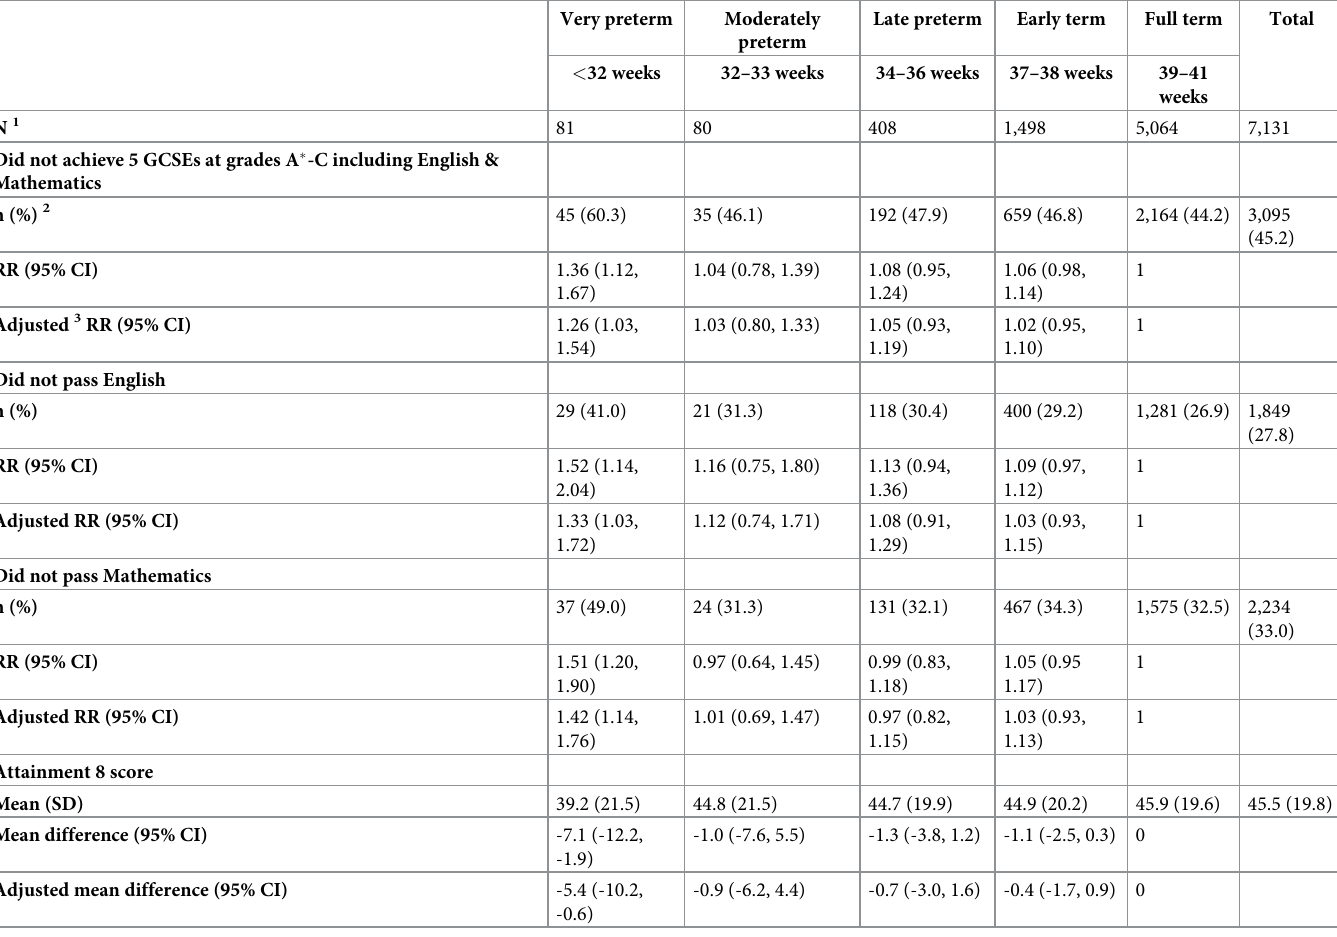
Table 5. The association between gestational age at birth and GCSE outcomes at the end of secondary school (Key Stage 4; age 16) within the Millennium Cohort Study